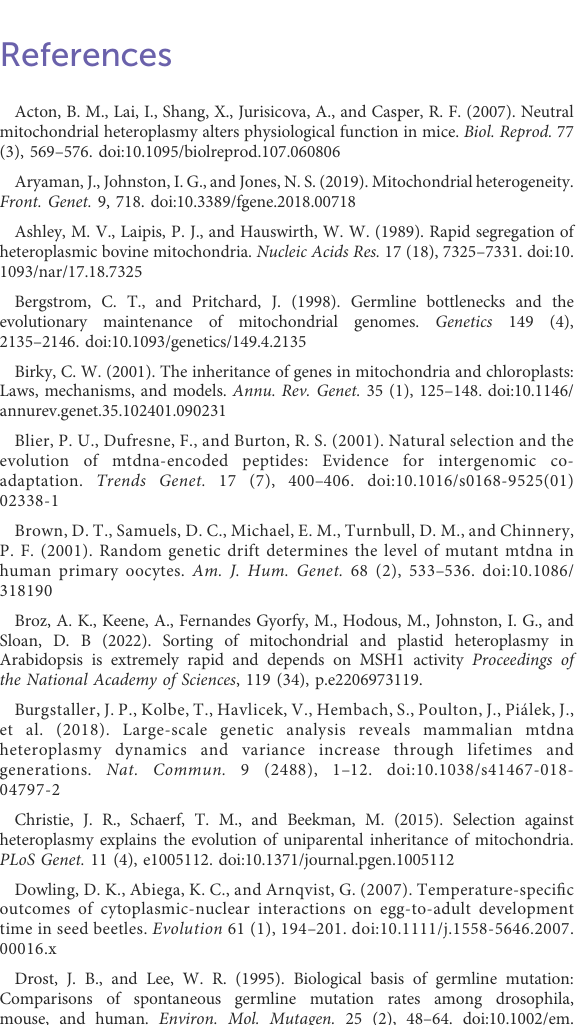
SUPPLEMENTARY FIGURE S4 Adaptation behaviour under alternative fi tness functions. Mean proportion of adapted genomes for (A) quadratic fi tness penalty 4 ε ( h − 1/2) 2 ; (B) large threshold ( fi xed penalty ε for h > 0.5); (C) small threshold